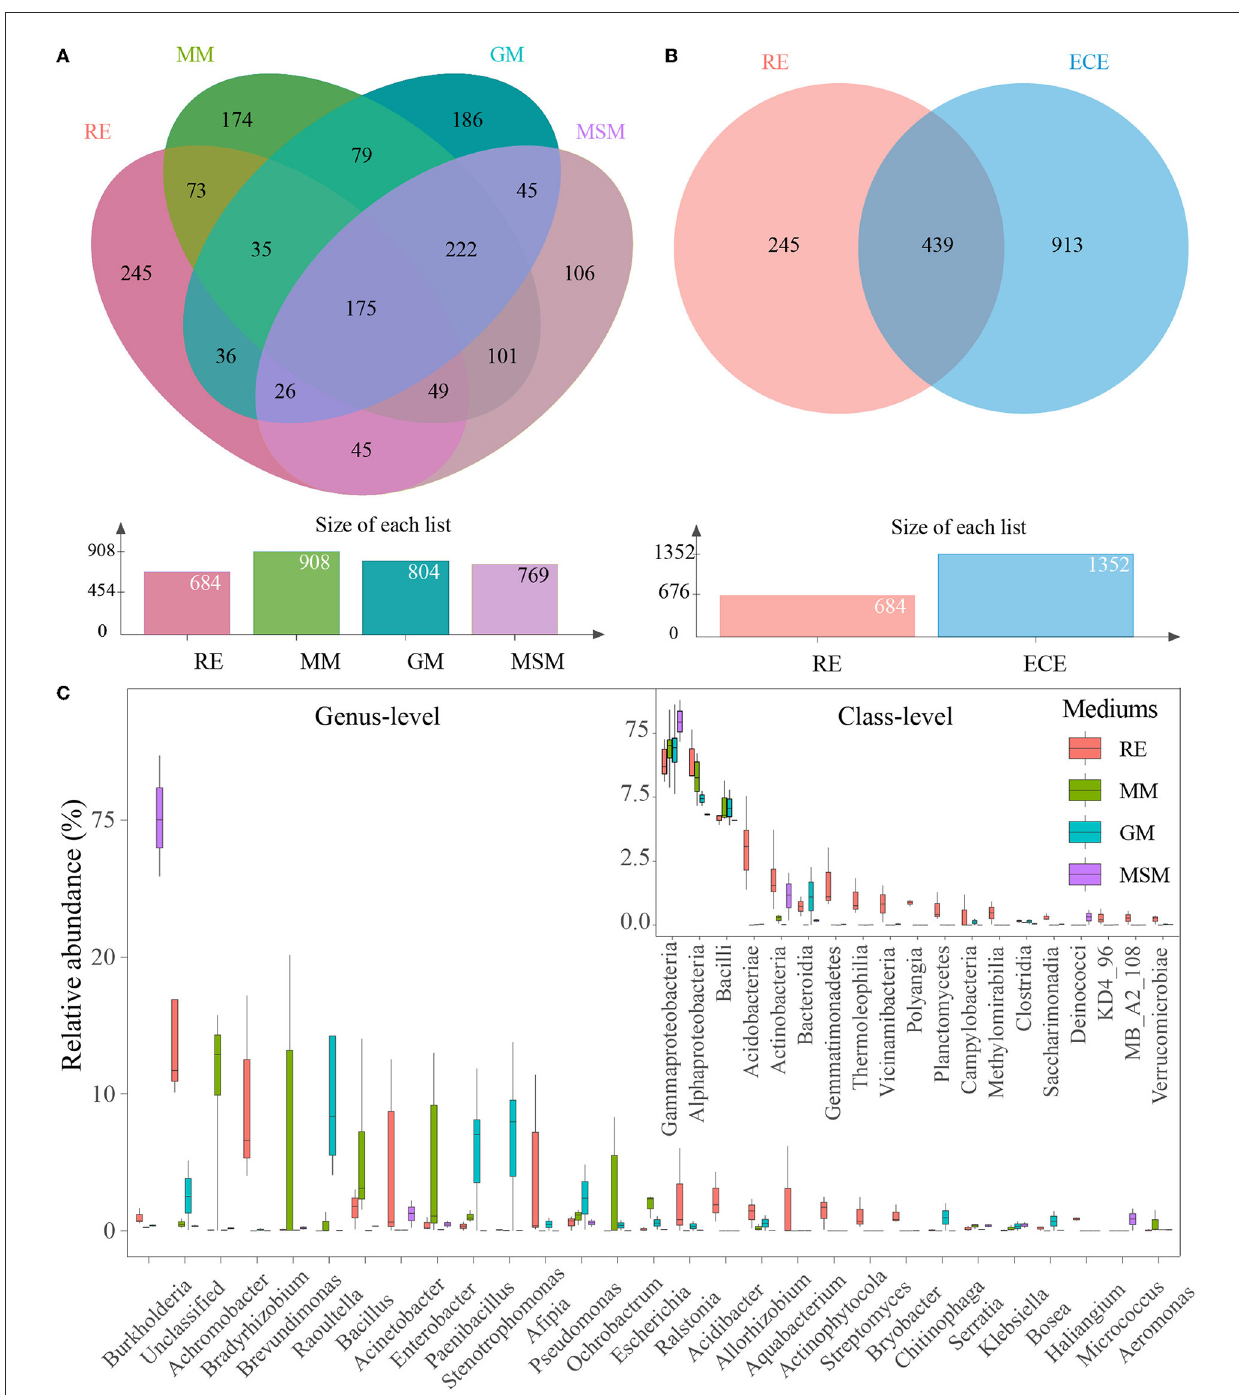
FIGURE2 Composition variance of the root endophytic bacterial communities after the enrichment. (A) OUTs composition differences between four experimental groups. (B) OUT composition differences between the in situ root samples and the enrichment collections. (C) Composition of shared bacterial taxa (439 OTUs) between the in situ root samples and the enrichment collections. These two plots show the top 19 most abundant classes and the top 30 most abundant genera of bacterial communities in all experimental groups, respectively. Table 1 presents a list of abbreviations of the groups used in the